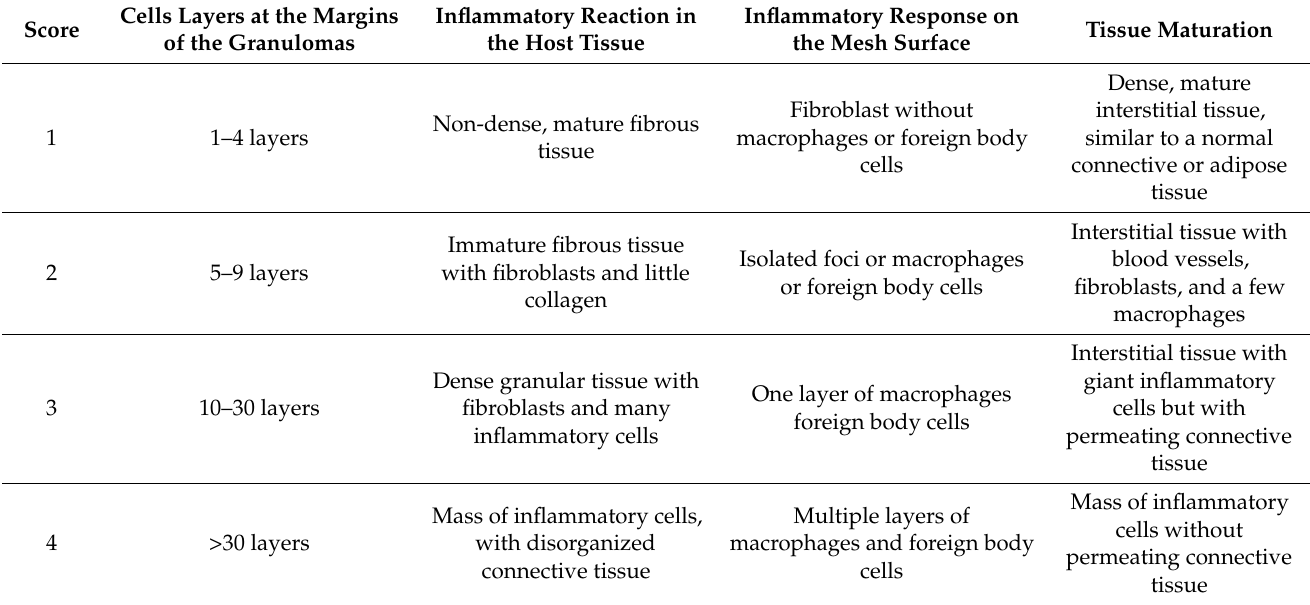
Table 3. Numeric scales to evaluate tissue inflammatory response in groups (Pereira-Lucena et al., 2014) [9]. Cells Layers at the Score